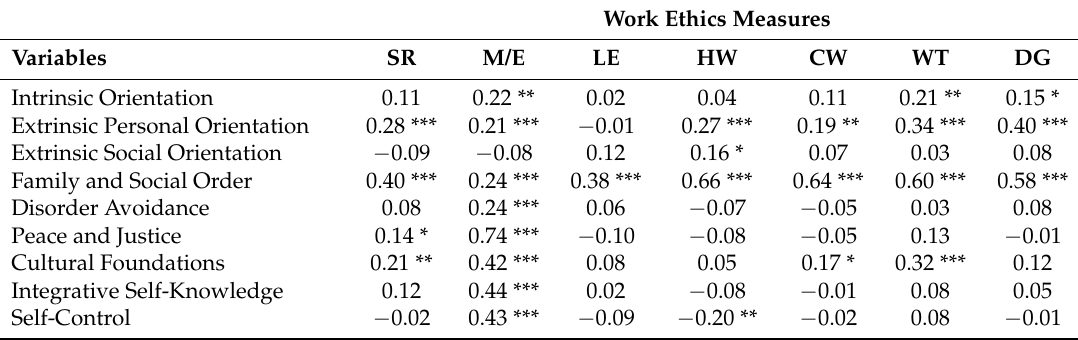
Table 3. Relationships of Work Ethics Measures with Religious Orientations, Integrative Self-Knowledge, and